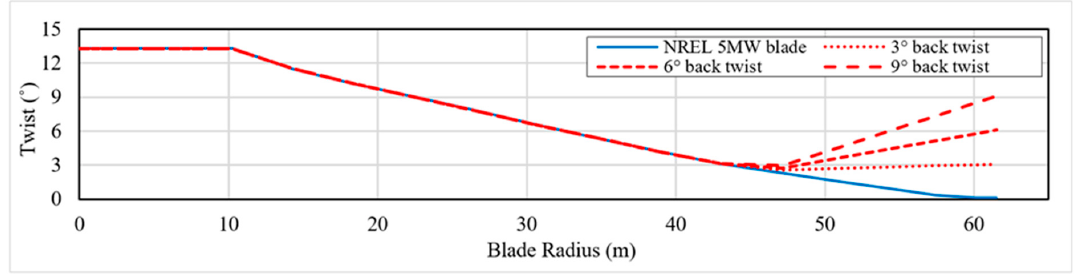
Figure 3. Twist profiles for pitch-to-stall blades in the tower axial fatigue life study.